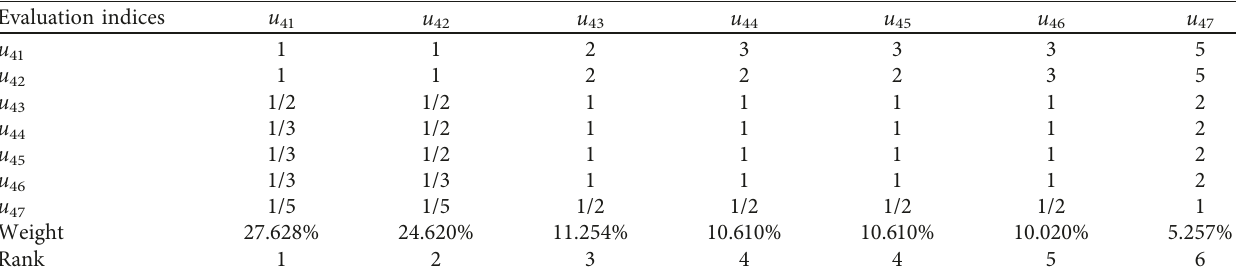
Table 7: Weights and rank of the shield machine design.